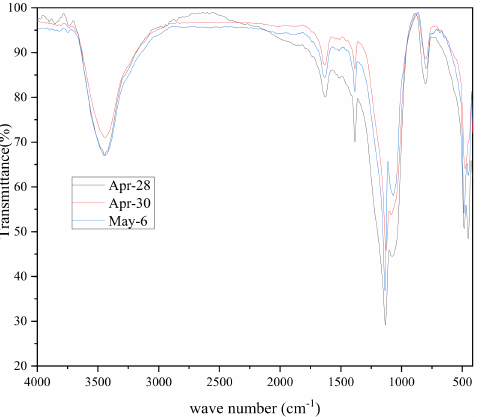
Figure 3. Infrared spectrograph results of particles collected on 28 April, 30 April and 6 May in 2021 in